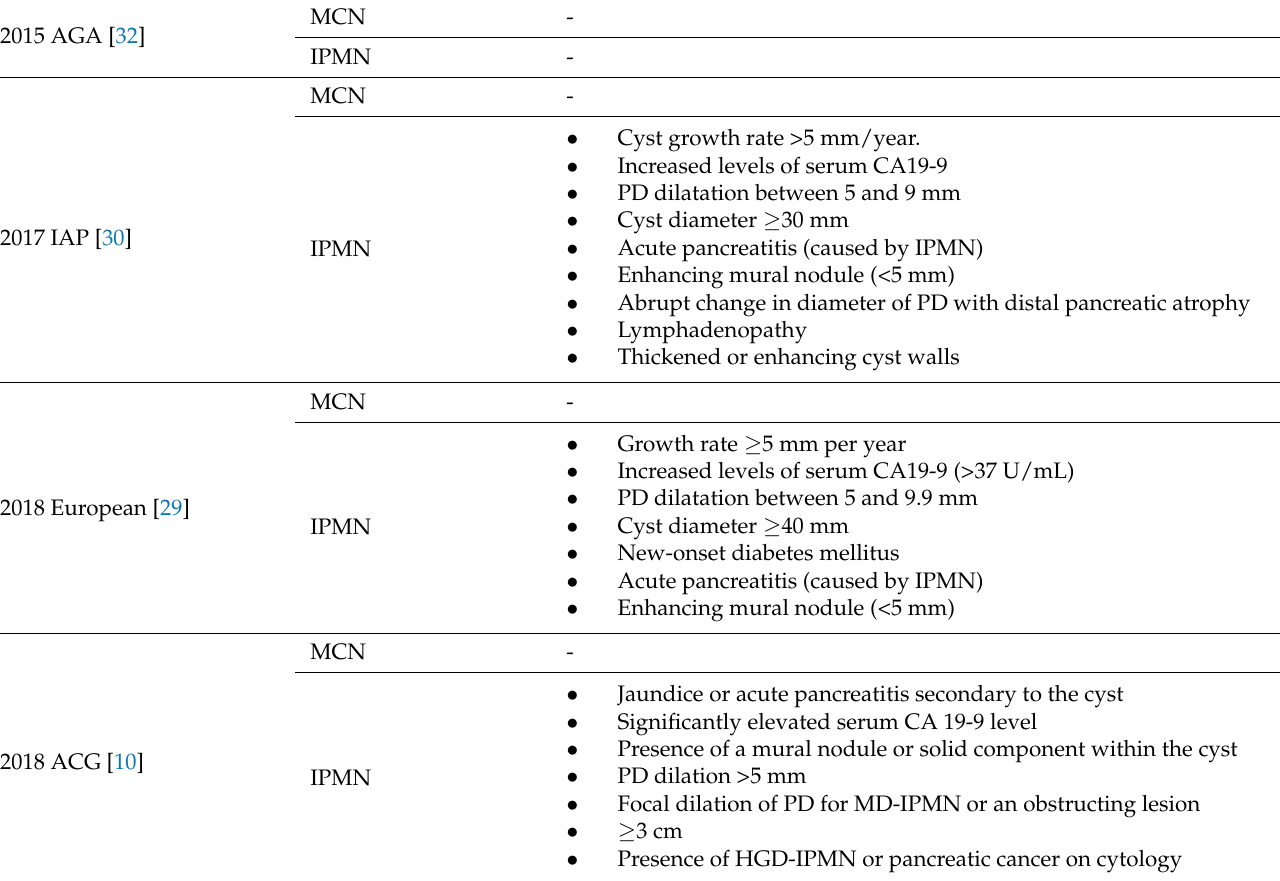
Table 3. Relative Indications for Surgical Resection of Pancreatic